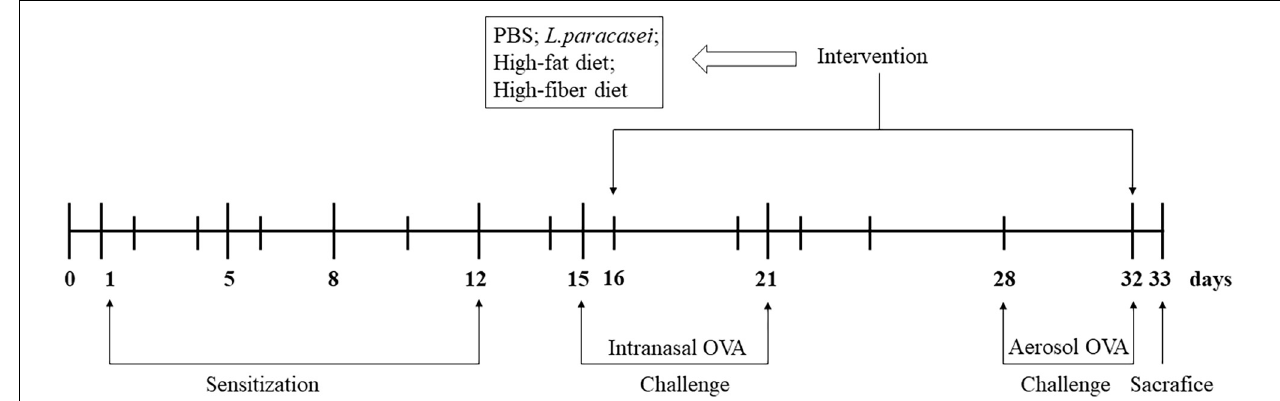
FIGURE 1 | Experimental design of a model of allergic asthma in rats. Male Wistar rats were sensitized and challenged with OVA, as described in “Animals and Intervention Design” section. Groups were allocated as Con, Model, Probio, Hfat, and Hfiber. From day 16 until day 32, rats were treated daily with Lactobacillus paracasei , and then randomly assigned to receive basic chow, high-fat chow or high-fiber chow. Rats in the Con group and Model group received PBS only. All rats were sacrificed on day 33 after documentation of allergic